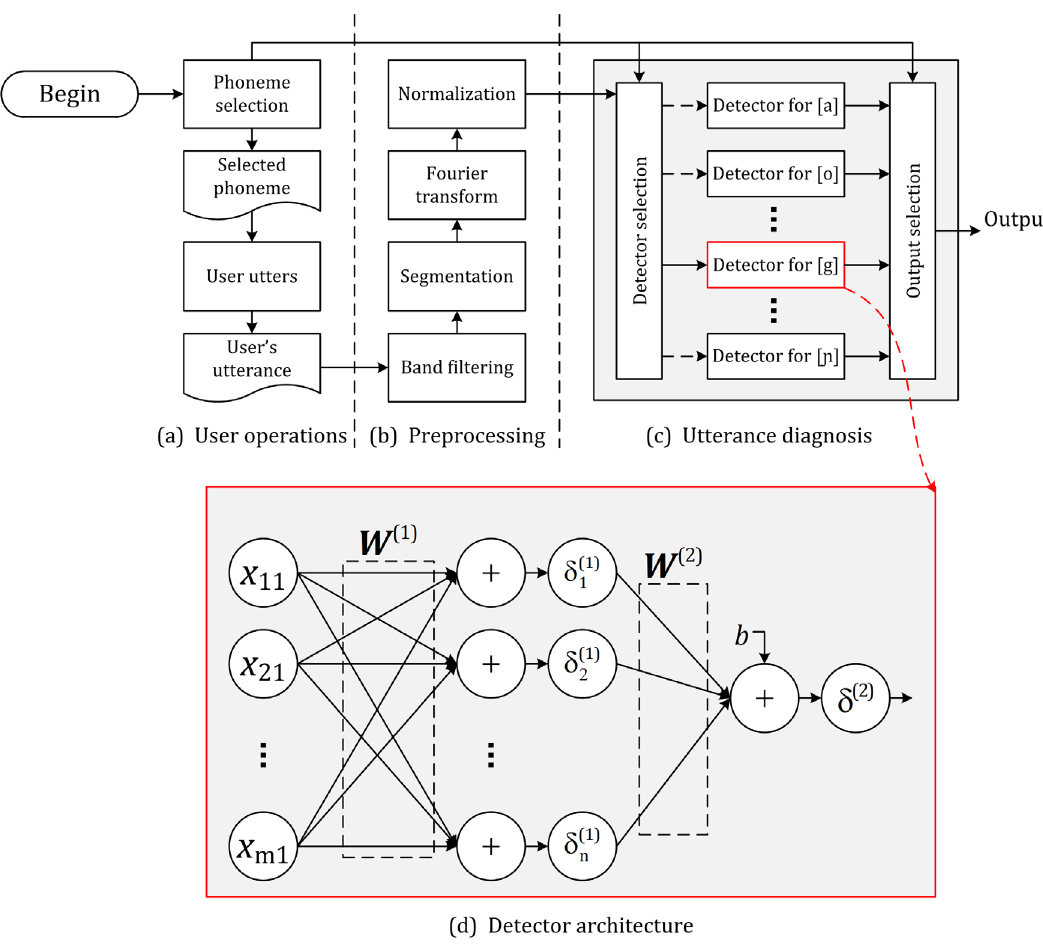
Fig 2. Proposed French CAPT framework.